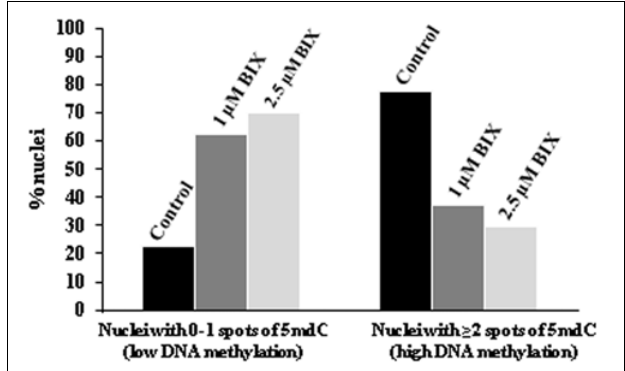
FIGURE 13 | Quantification of effects of BIX-01294 on DNA methylation (5mdC) nuclear distribution patterns in microspore proembryos. Quantification of the percentage of nuclei showing: (a) 0 or 1 spot of 5mdC per nucleus (low DNA methylation), and (b) 2 or more spots of 5mdC per nucleus (high DNA methylation) in control, 1 and 2.5 µ M BIX-treated proembryos of Brassica